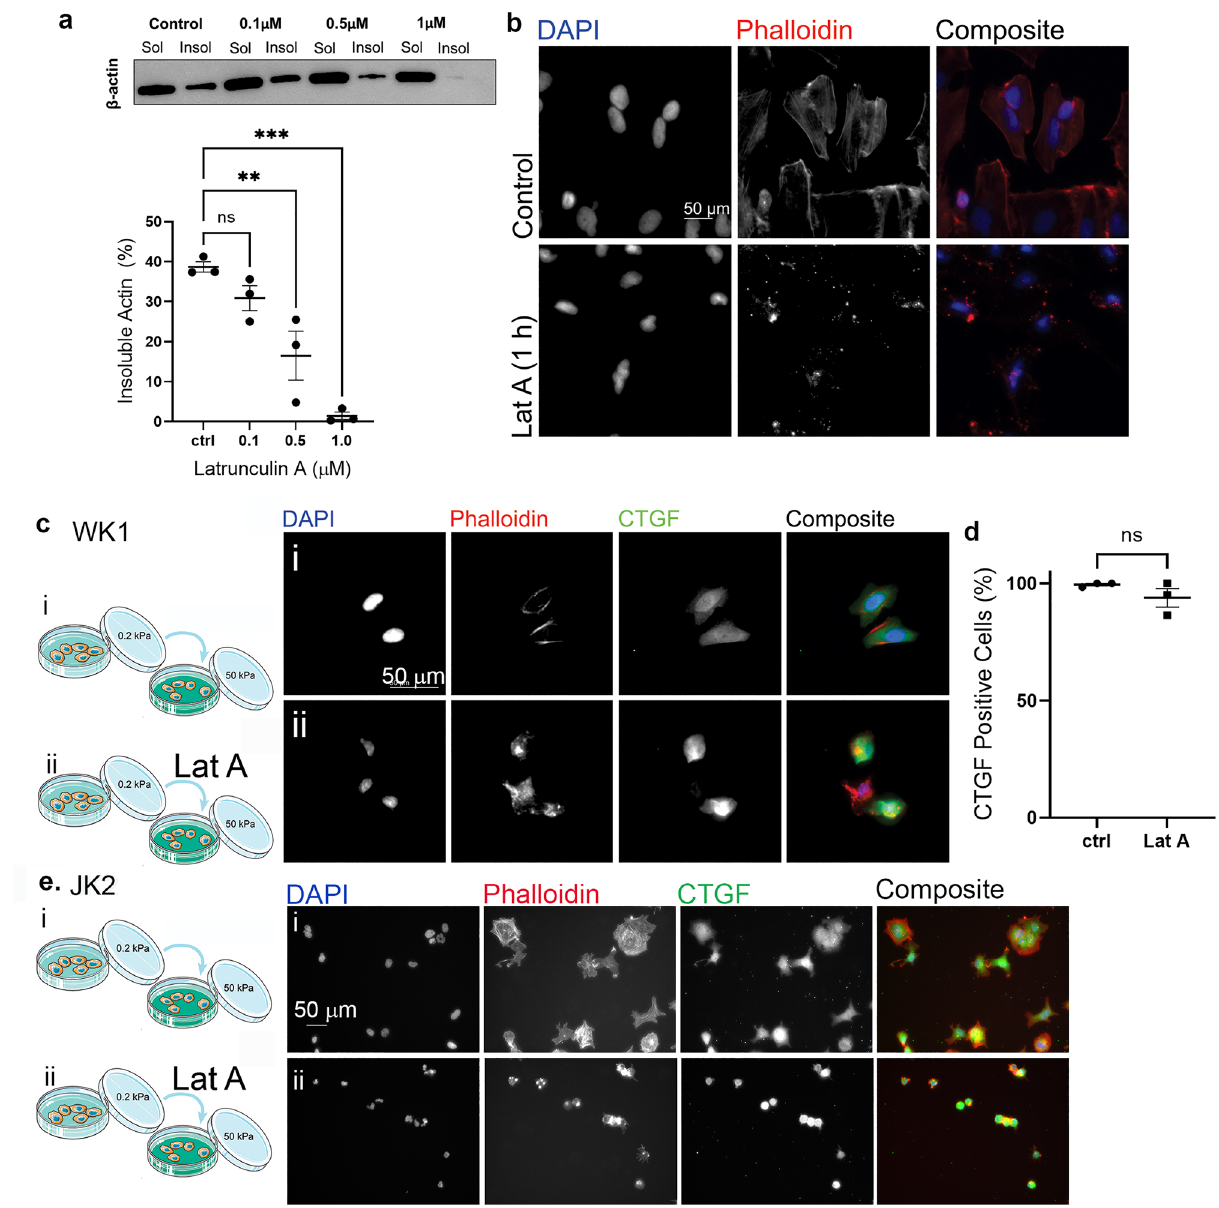
Figure 4. Mechanosensitive CTGF expression precedes actin filament organization. ( a ) The concentration of Latrunculin A required to disassemble actin filaments was determined by western blot analysis of the insoluble versus soluble β-actin fraction following treatment of cells grown in plastic tissue culture dishes with the indicated Latrunculin A concentrations. Data points in graph show mean proportion of insoluble actin in WK1 cells as a percentage of the total β-actin (sum of insoluble plus soluble fraction) from three independent biological repeats. Error bars indicate ± SEM. Symbols denote statistical significance: **p < 0.01; ***p < 0.001; N = not significant (p < 0.05); One-way ANOVA with Tukey’s post-test. ( b ) Control untreated cells and cells treated with 0.5 µM Latrunculin A for 1 h, as indicated, grown on glass coverslips. Cells were fixed and stained with DAPI to show nuclei and phalloidin to detect F-actin. ( c ) WK1 cells cultured on 0.2 kPa gels were detached and replated onto 50 kPa gels either untreated (i, top row, ctrl) or in the presence of 0.5 µM Latrunculin A (ii Lat A, bottom row) as indicated in the schematic. Cells were then fixed and immunostained with anti-CTGF, DAPI to detect cell nuclei and phalloidin to detect F-actin—shown individually in grey scale and as a colour overlay in the final column. ( d ) Quantification of percentage of CTGF positive cells from the conditions described in ( c ). Data points represent three independent biological repeats. Error bars indicate ± SEM. Symbols denote statistical significance: N = not significant (p < 0.05); Students’ t -test. ( e ) JK2 cells. Scale bars = 50